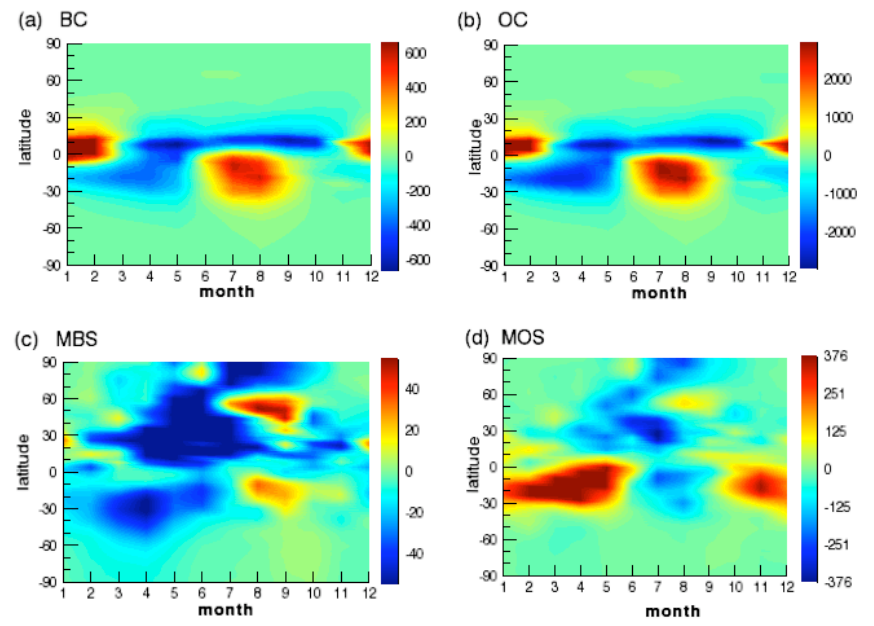
Fig. 5. Hovm¨oller diagram of zonal monthly means of differences in column loading (g/km 2 ) due to seasonal BBCA emissions in online runs of: (a) BC, (b) OC, (c) MBS, and (d)